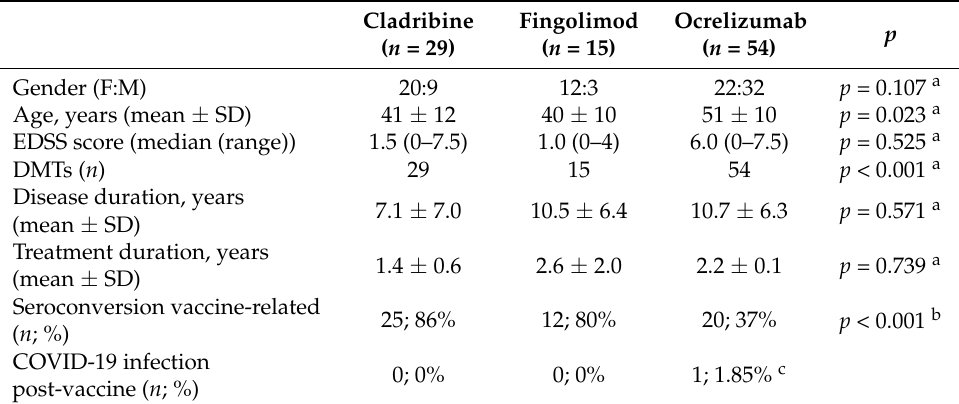
Table 1. Demographic, clinical and seroconversion COVID-19 vaccine-related